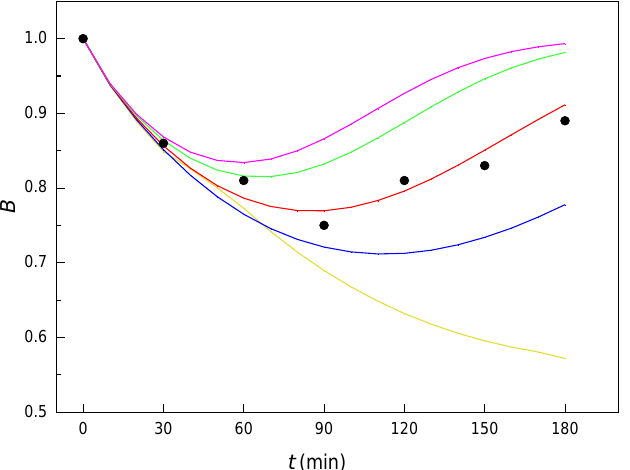
Figure 4. The course of the theoretical B ( t ) curves calculated with the optimized constants K 1 – K 5 (see Table 2) for various values of the molar ratio n (yellow curve: n = 0.1; blue curve: n = 0.3; red curve: n = 0.5; green curve: n = 0.8; violet curve n : = 1.0; black circles—experimental points). For comparison, Figure 5 depicts the shape of the B(t) curves calculated with the optimized kinetic parameters, together with the experimentally obtained points for the interaction of α E2 with (A) mouse sperm [7] and (B) rat sperm for a dose concentration of 200 µ